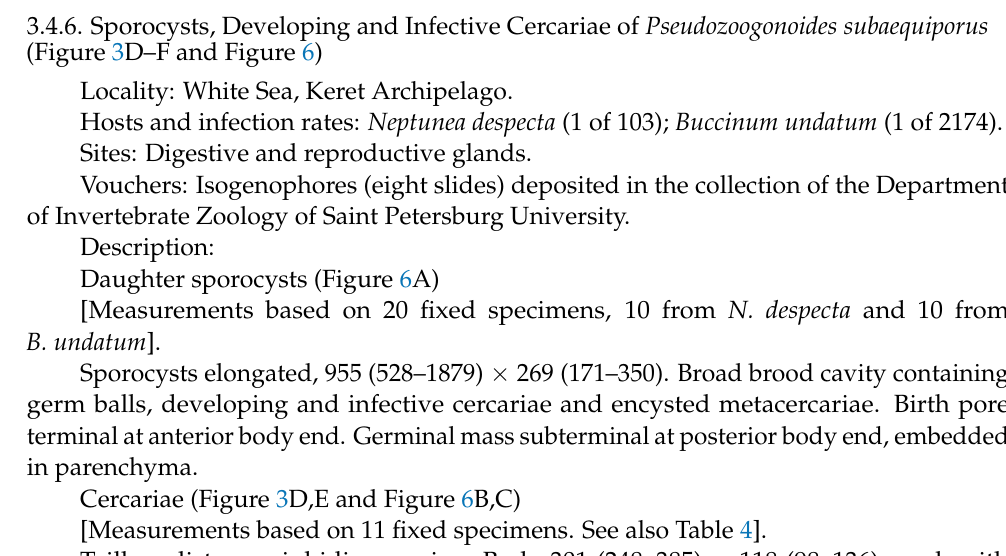
Locality: White Sea, Keret